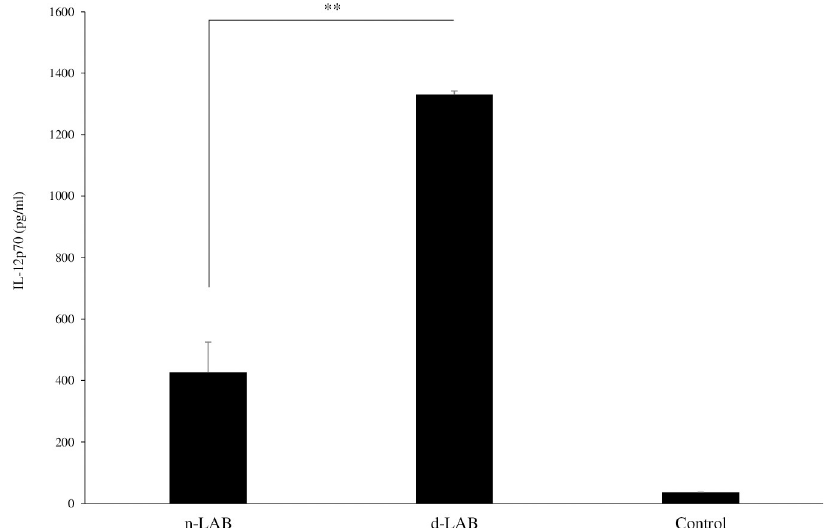
Fig 4. Effect of n-LAB and d-LAB administration on IL-12 production in mouse splenocytes. n-LAB and d-LAB were co-cultured with mouse splenocytes for 24 h. IL-12 concentration in the culture supernatant was measured using enzyme-linked immunosorbent assay. Control, culture medium only; d-LAB, dispersed lactic acid bacteria; n-LAB, non-treated lactic acid bacteria. Each value is presented as the mean ± SD; n = 6; �� p < 0.01 vs. n-LAB.